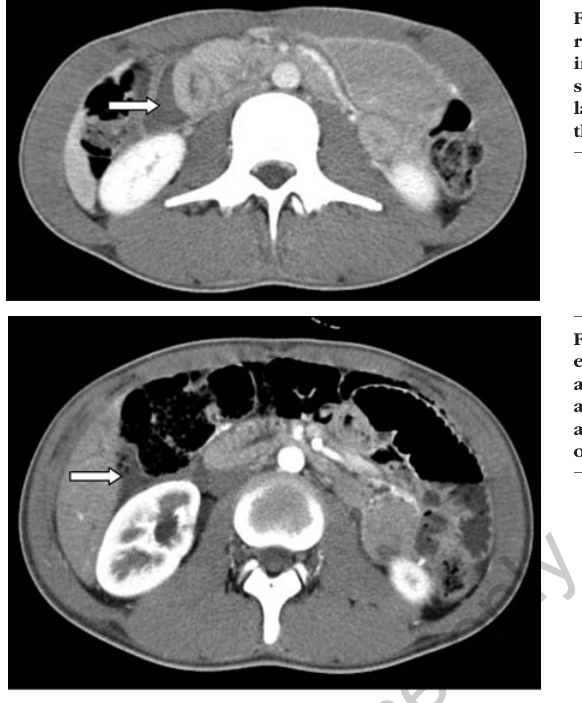
Figure 3. Follow-up comput- ed tomography scan of the abdomen 16 days after admission showing the almost complete resolution of the hematoma (arrow).